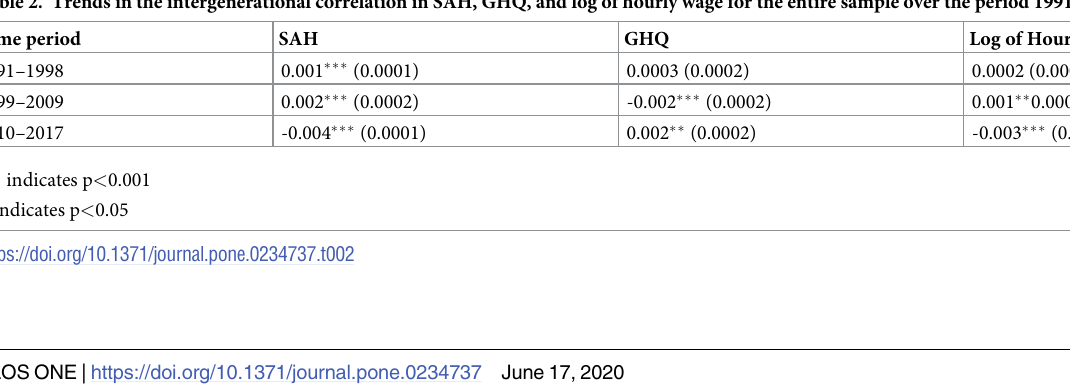
manual occupations and professional occupations. In Table 5, the intergenerational correla- has been no real change in the correlation in GHQ.